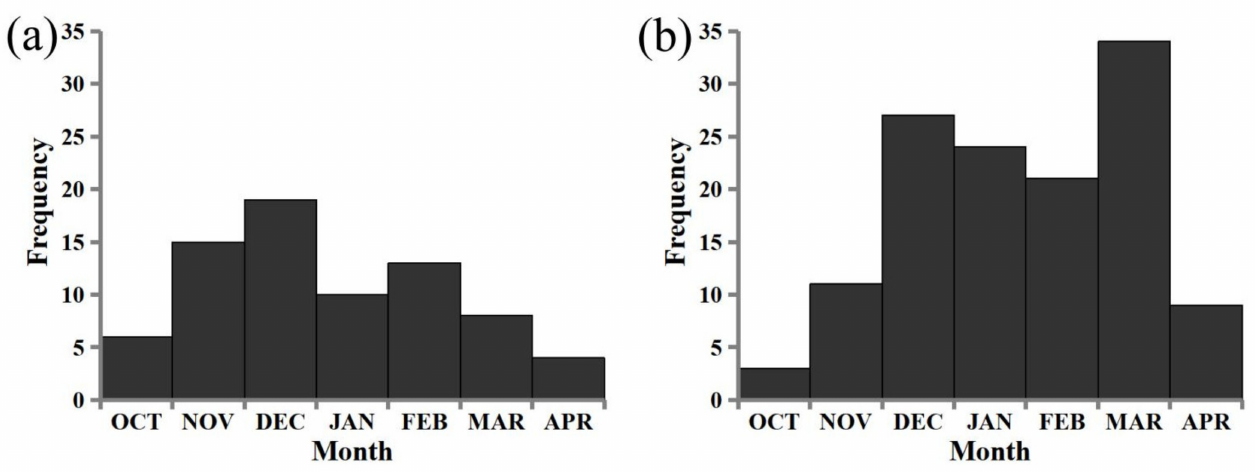
Figure 2. The monthly frequency of ECs over ( a ) the Japan Sea and ( b ) Kuroshio/Kuroshio